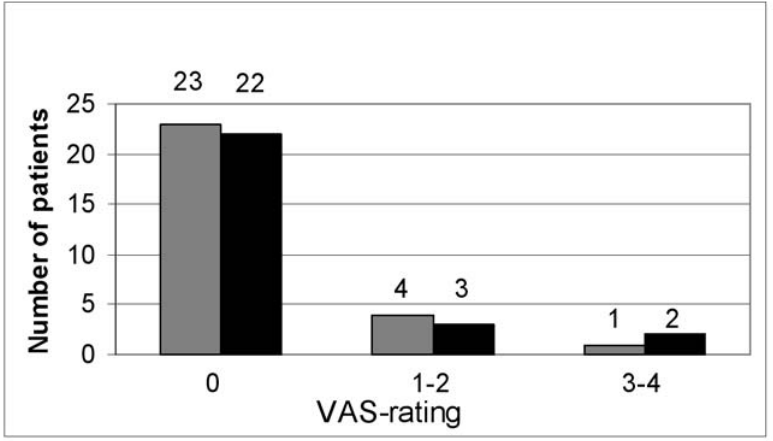
Fig. 2.b VAS-rating 60 minutes after removal of the Laryngeal mask Airway (LMA) and Laryngeal Tube (LT), grey = LMA , black =LT.